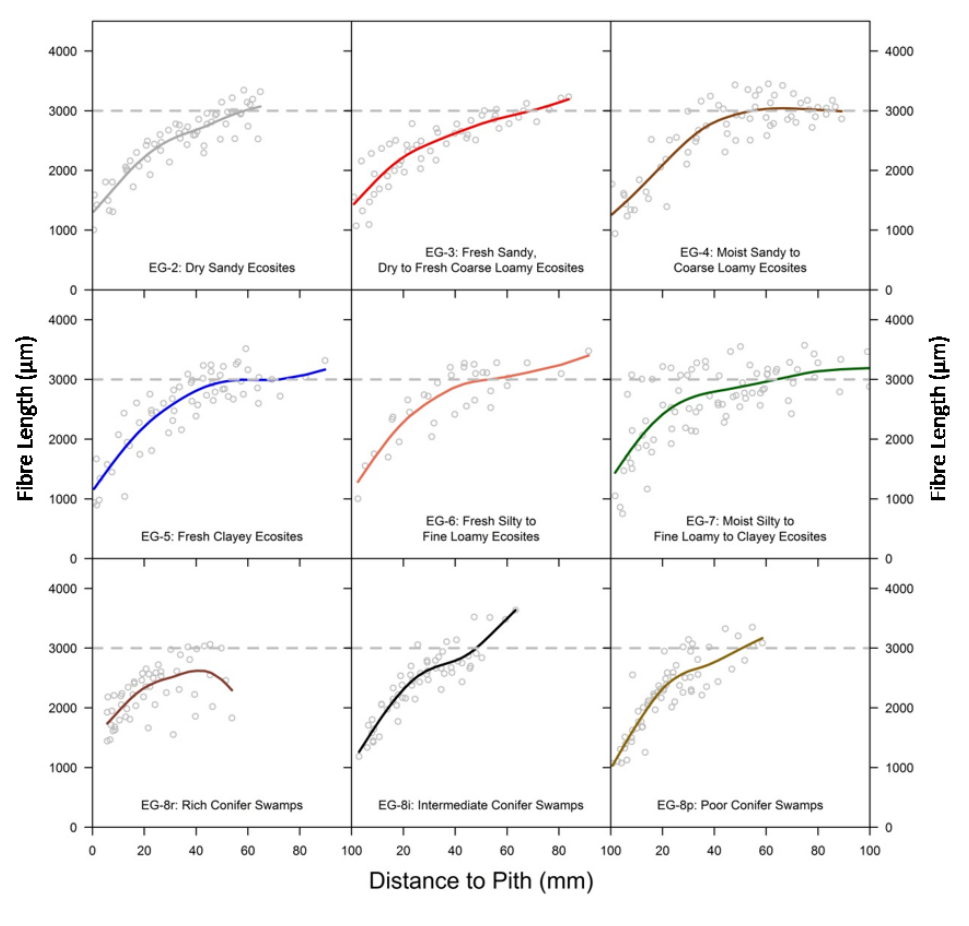
Figure 7. The fibre length response curve (mean fibre length against distance from the pith (mm)) at breast height of black spruce increment cores representing different ecosite groups collected from the boreal forest of north eastern Ontario from 2010–2011. The curve was fit with a cubic smoothing spline with five degrees of